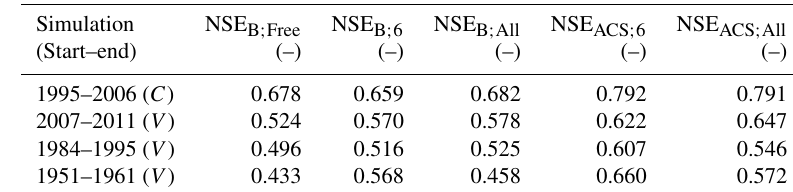
Table 5. Nash–Sutcliffe efficiencies of the benchmark and ACS model.